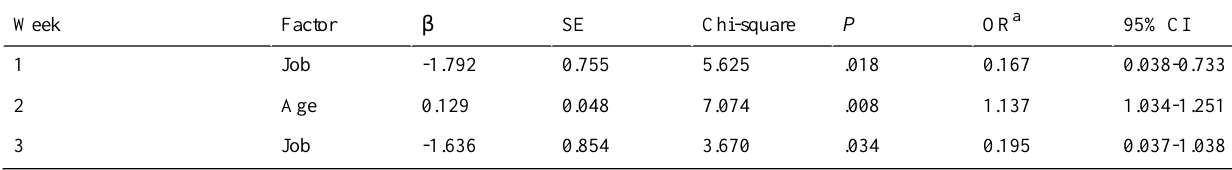
Table 3. Logistic regression of concordance between the ecological momentary assessment and the urine test.